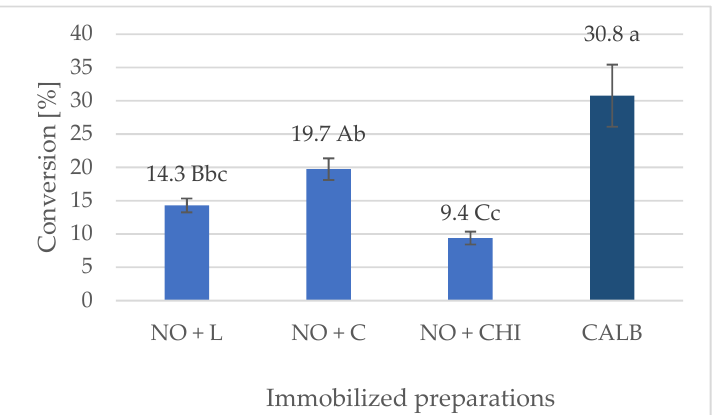
Figure 6. Conversion of vinyl acetate into acetaldehyde based on the colorimetric assay method with the immobilized preparations: NO + L: liquid lipase Novozym 51032 immobilized on Lewatit VP OC 1600; NO + C: liquid lipase Novozym 51032 immobilized on coffee grounds; NO + CHI: liquid lipase Novozym 51032 immobilized on chitosan powder; CALB: immobilized lipase B from C. antarctica as a reference. Means with the same capital letter A, B, or C in the case of liquid lipase Novozym 51032 immobilized on different supports, and a, b, or c in the case of all biocatalysts, did not differ significantly (α = 0.05).